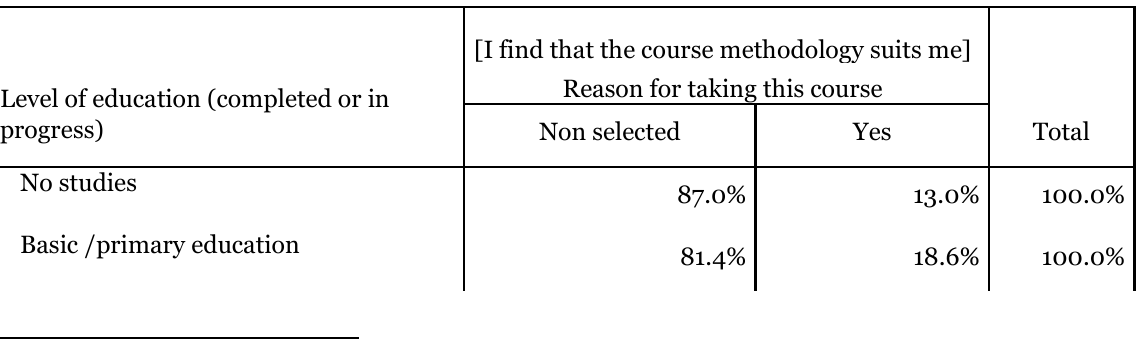
Level of Education (Completed or in Progress) by Reason for Taking this Course Cross-Tabulation: I Find That the Course Methodology Suits